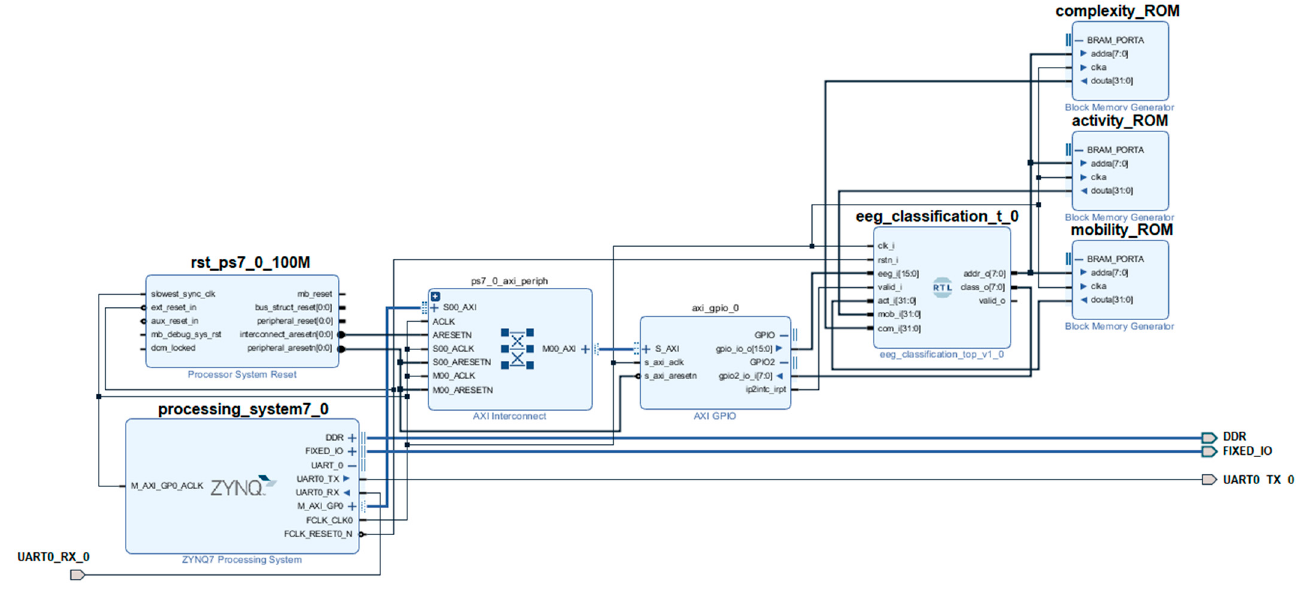
Figure 8. Top-level system in Vivado implementation; the proposed algorithm is integrated with other blocks such as ROM and the Zynq processor for further development.